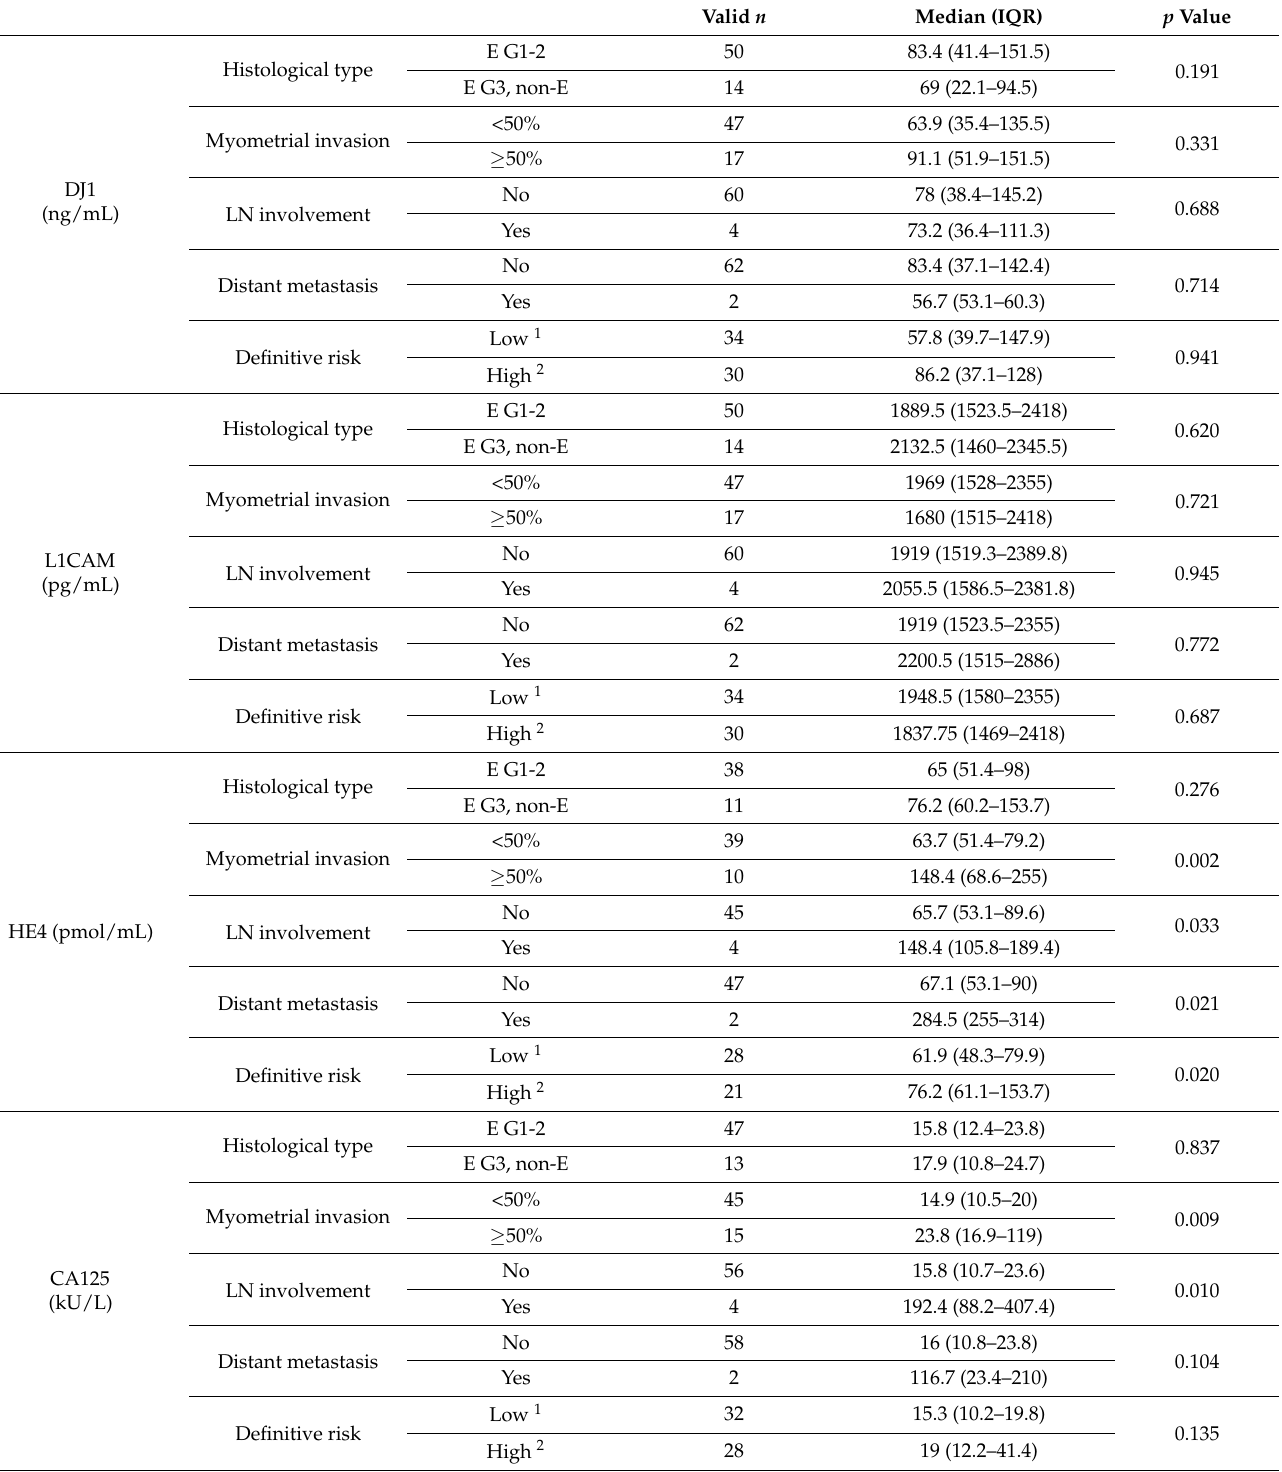
Table 6. DJ1, L1CAM, HE4 and CA125 serum levels in correlation with both clinical and pathological features of endome- trial